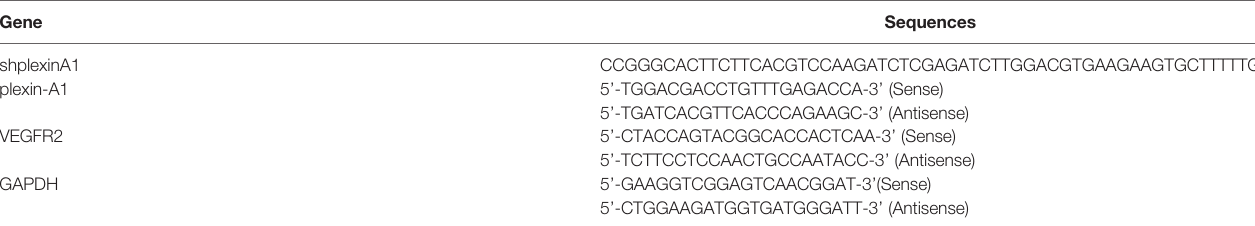
TABLE 1 | Primer sequences and interference of sequence used in this